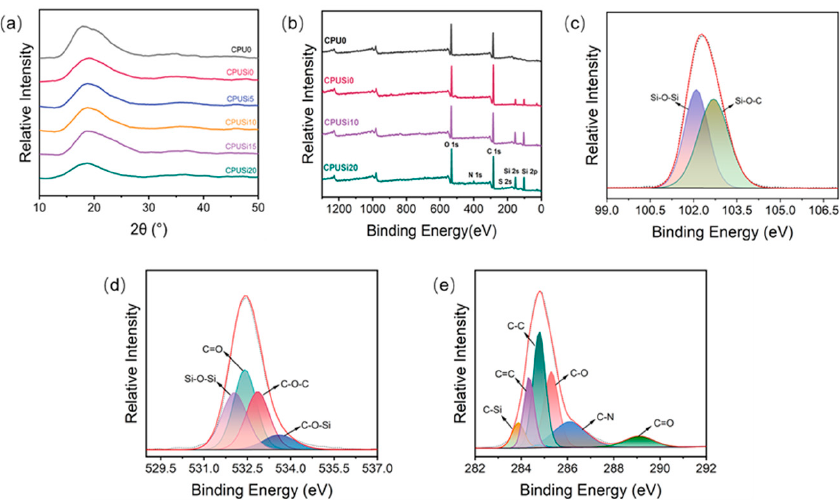
Figure 3. ( a ) X-ray diffractograms of different CPU and CPUSi films; ( b ) XPS spectrum of the film surface of CPU0, CPUSi0, CPUSi10, and CPUSi20 films; ( c ) XPS spectra of Si 2p of CPUSi20 film; ( d ) XPS spectra of O 1s of CPUSi20 film; ( e ) XPS spectra of C1s of CPUSi20 film.